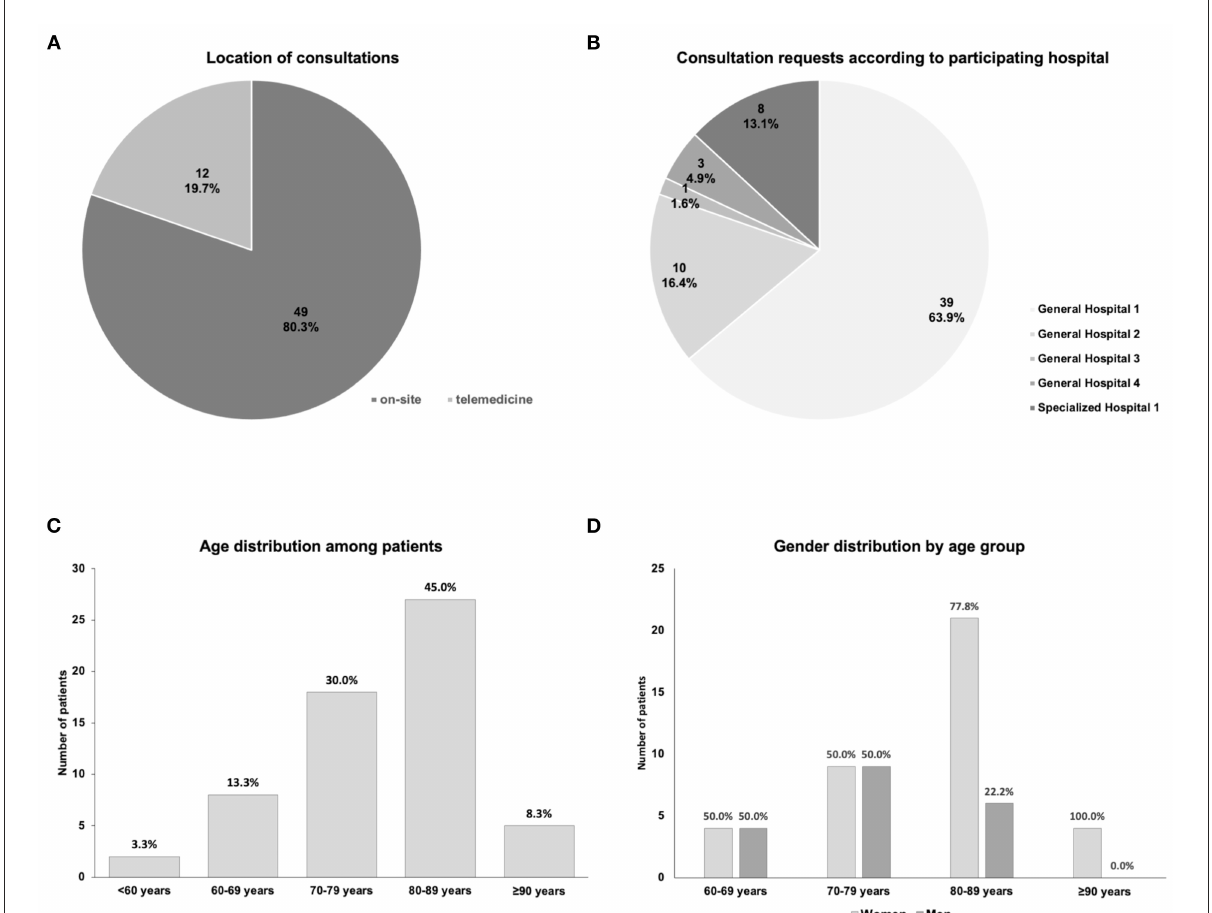
FIGURE1 Basic conditions of the consultation service. (A) Proportions of consultations performed on-site or via telemedicine. (B) Distribution of the consultation requests among the participating hospitals. (C) Age distribution among the patients for whom consultations were requested. (D) Age distribution, separated by